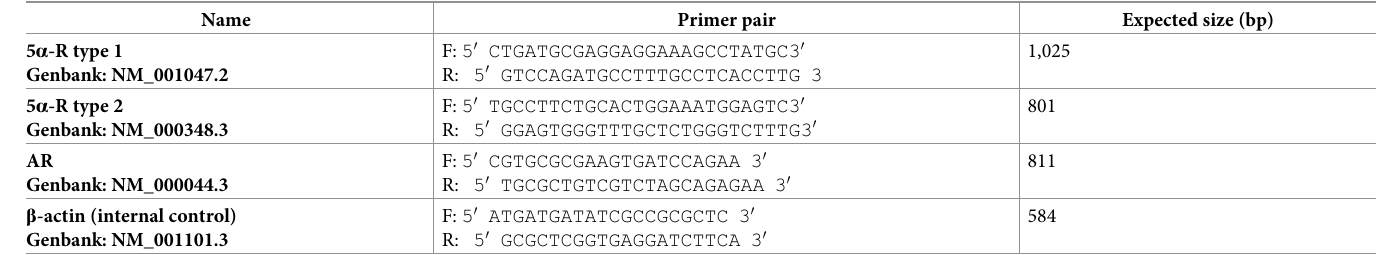
Table 1. Forward and reverse primers, and the expected sizes of the 5 α -R enzymes, the AR, and β -actin.